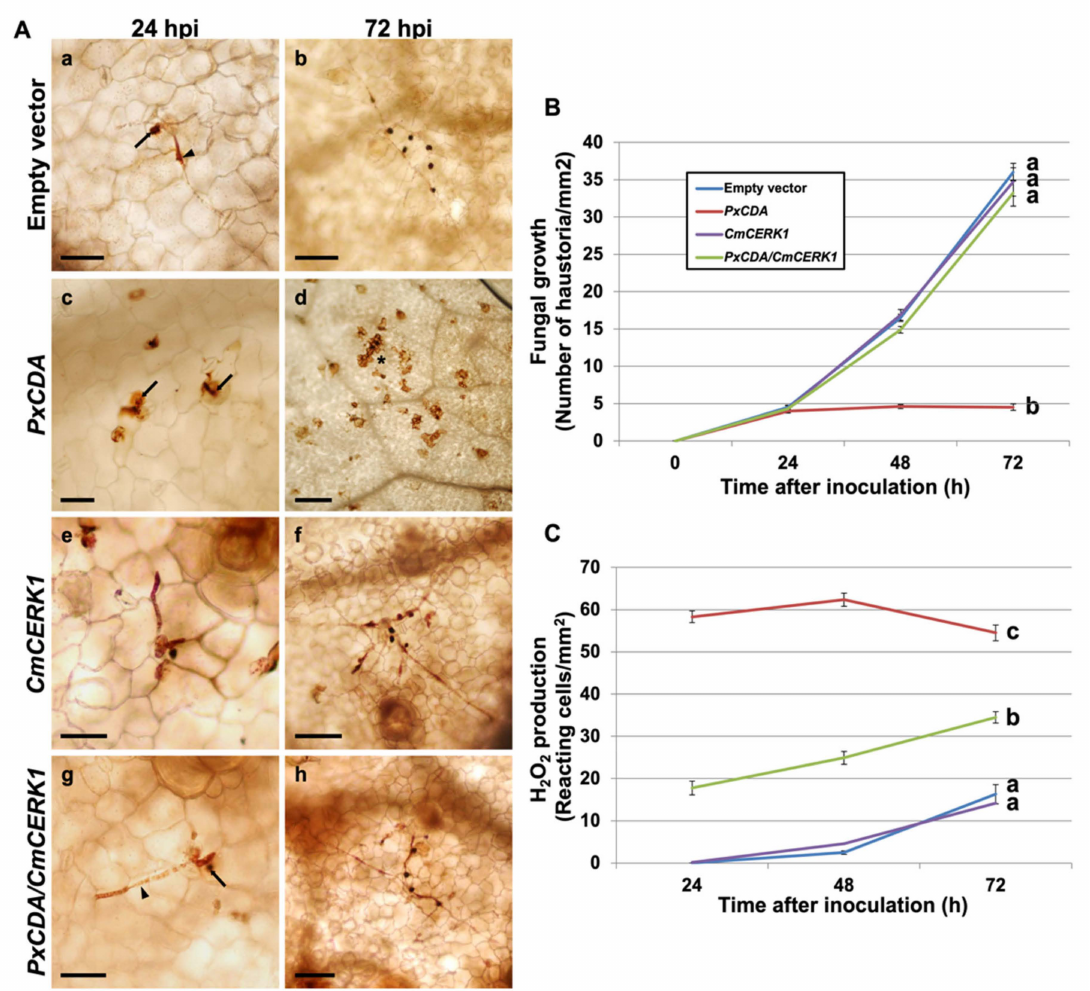
Figure 2. Effect of silencing PxCDA on fungal growth and production of hydrogen peroxide. RNA interference (RNAi) silencing was carried out by A. tumefaciens -mediated host-induced gene silencing. An empty vector was used as a negative control. Silencing of the melon chitin receptor gene CmCERK1 was carried out to interfere with host chitin signalling. ( A ) Visualization of fungal structures and H 2 O 2 -producing cells. The detection of hydrogen peroxide was performed by the 3,3 (cid:48) -diaminobenzidine (DAB) uptake method. Pictures were taken at 24 and 72 h after inoculation with P. xanthii . Arrowheads indicate P. xanthii haustoria; arrows indicate P. xanthii hyphae, and asterisks indicate reactive epidermal cells with H 2 O 2 accumulation. Bars = 50 µ m ( a , c , e , g ), 100 µ m ( b , f , h ), and 200 µ m ( d ). ( B ) Estimation of fungal growth by haustorial counting. The growth of P. xanthii is expressed as the number of haustoria per mm 2 of transformed tissue. The values are the means of 30 samples from three independent experiments ± standard error. ( C ) Time course analysis of the accumulation of H 2 O 2 in melon cotyledons. The detection of H 2 O 2 was performed by the DAB uptake method. The reactive epidermal cells were identified as those containing brown–red precipitates (asterisks). Data represent the number of reactive cells per mm 2 and are the means of 30 samples from three independent experiments ± standard error. Values with different letters in ( B , C ) are significantly different at p = 0.05 according to Fisher’s least significant difference test